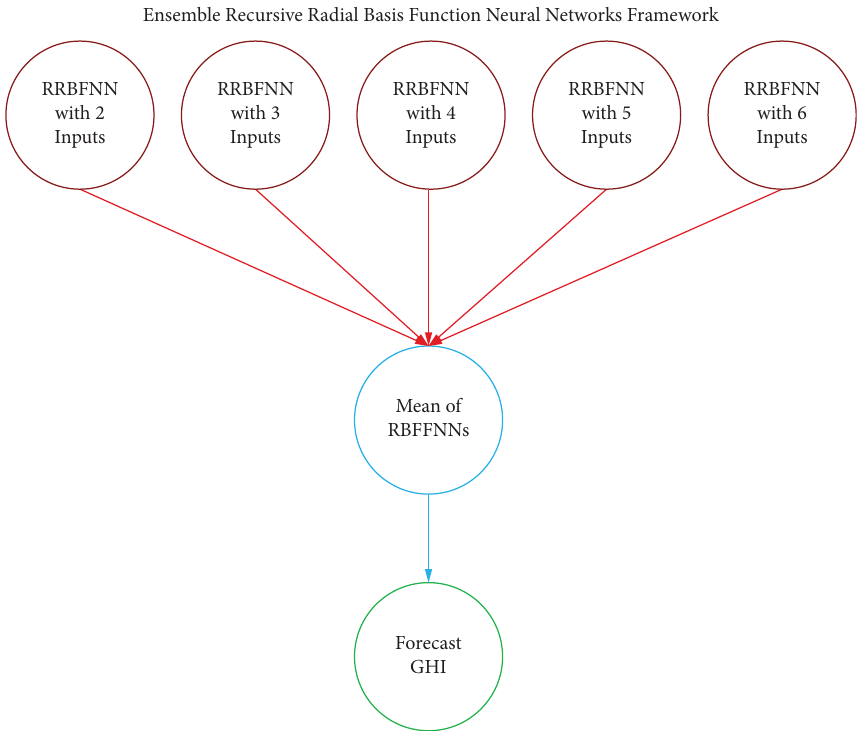
Figure 2: Proposed ERRBFNN framework.